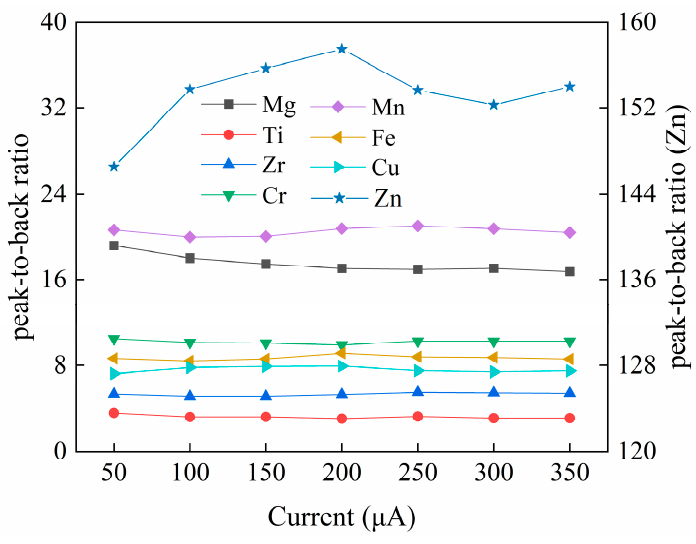
Figure 4. Peak-to-back ratio measured by X-ray tube at different currents.